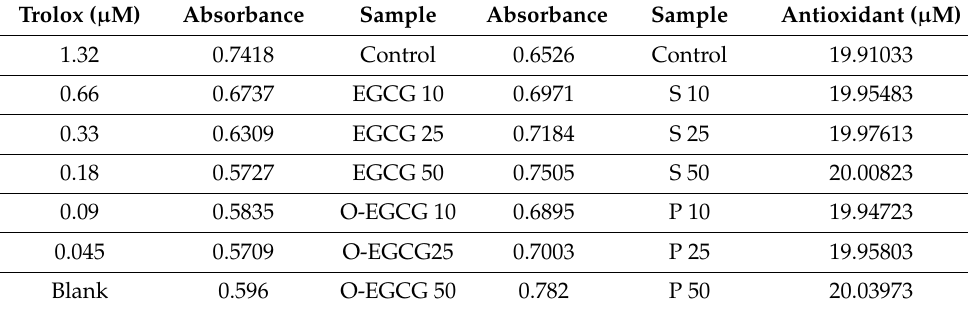
Figure 3. ( a ) Calibration curve of Trolox standard. ( b ) Levels of antioxidant in EGCG and O-EGCG. Table 2. Total antioxidant assay of EGCG and